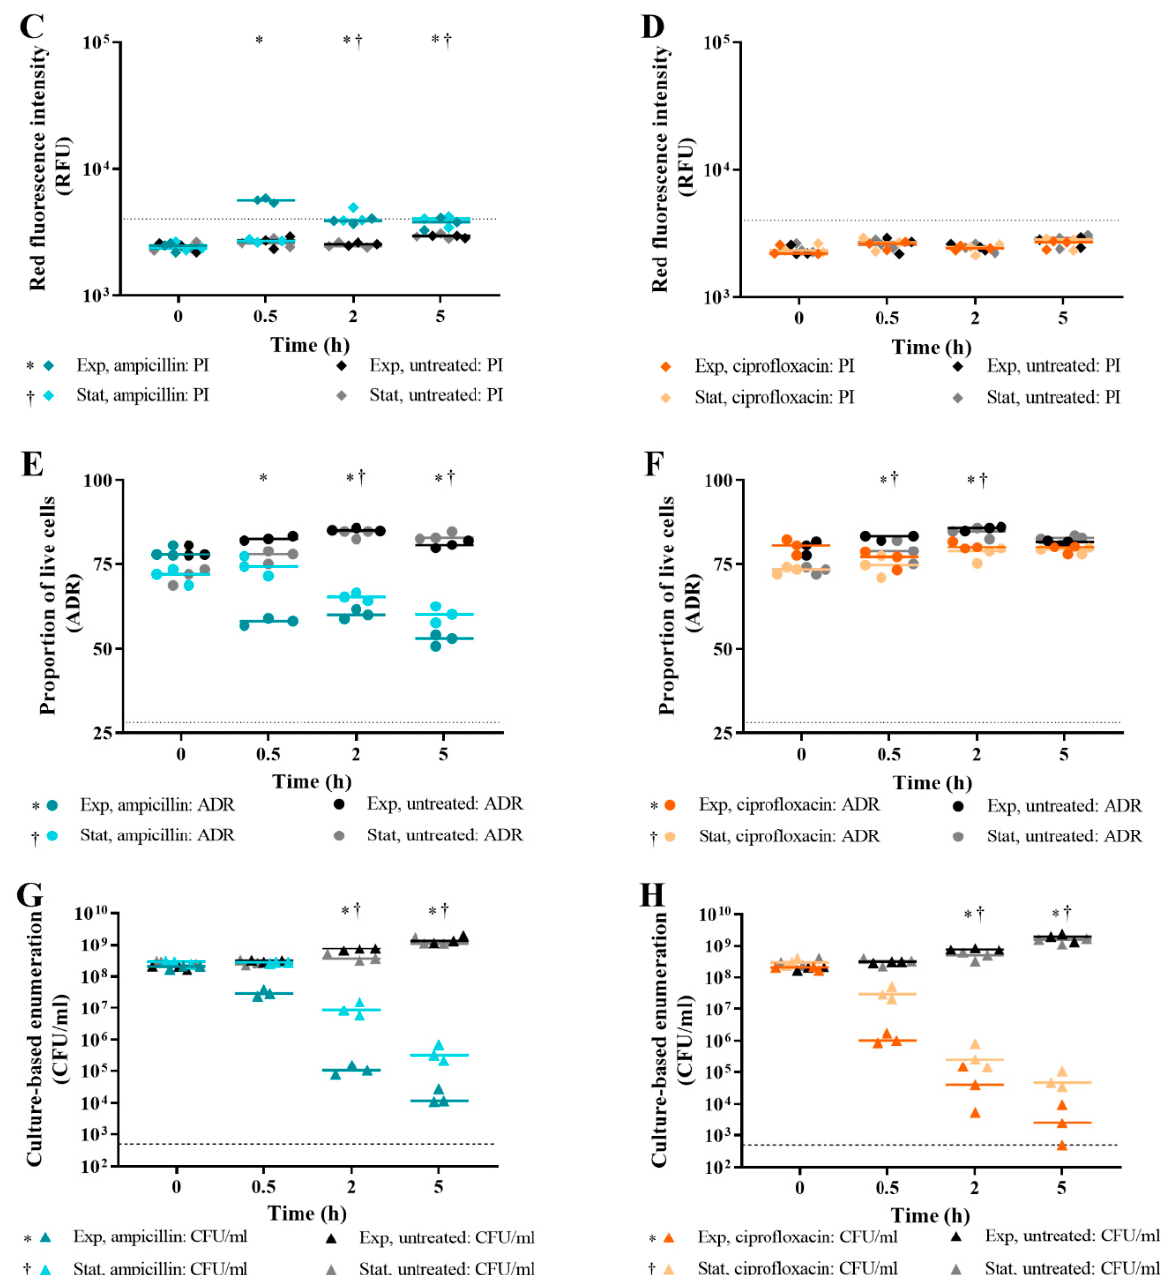
Figure 9. The impact of growth phase on E. coli live/dead spectrometry. At 0 h, 0.5 h, 2 h, and 5 h time points, viability of exponential- (exp) and stationary- (stat) phase E. coli MG1655 challenged with ~1 × MBC of ampicillin (teal and cyan, respectively) and of ciprofloxacin (dark orange and light orange, respectively) and an untreated control (black) was determined by measuring fluorescence of SYTO 9-, PI-, and SYTO 9- and PI-stained cultures using the Optrode and by culture-based enumeration ( G , H ). Fluorescence intensities were obtained from integrating 505–515 nm for green emissions and 600–610 nm for red emissions. The proportion of live cells in the sample population was determined by the impact of the quenching/enhancement dye interaction on green emissions ( A , B ); level of red emissions ( C , D ); and the adjusted dye ratio (ADR; E , F ). The dotted lines represent the equivalent value for isopropanol-killed cells. The limit of detection for viable cell plate counts is 500 CFU/mL (dashed line). Data presented is from three biological replicates with a line plotted at the median. Statistical significance for the difference between exponential phase treated and untreated is represented by * and between stationary phase treated and untreated is represented by † (two-way RM ANOVA, p value: <0.05, Tukey multiple comparisons